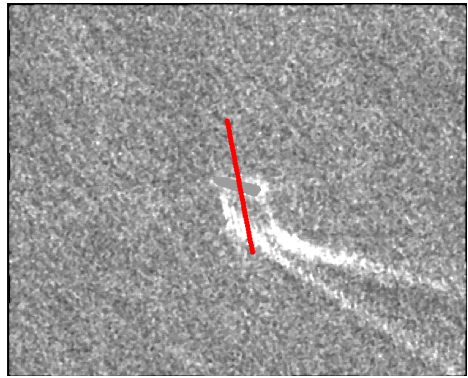
Figure 9. Azimuth line direction. The wake search is performed on the red linear